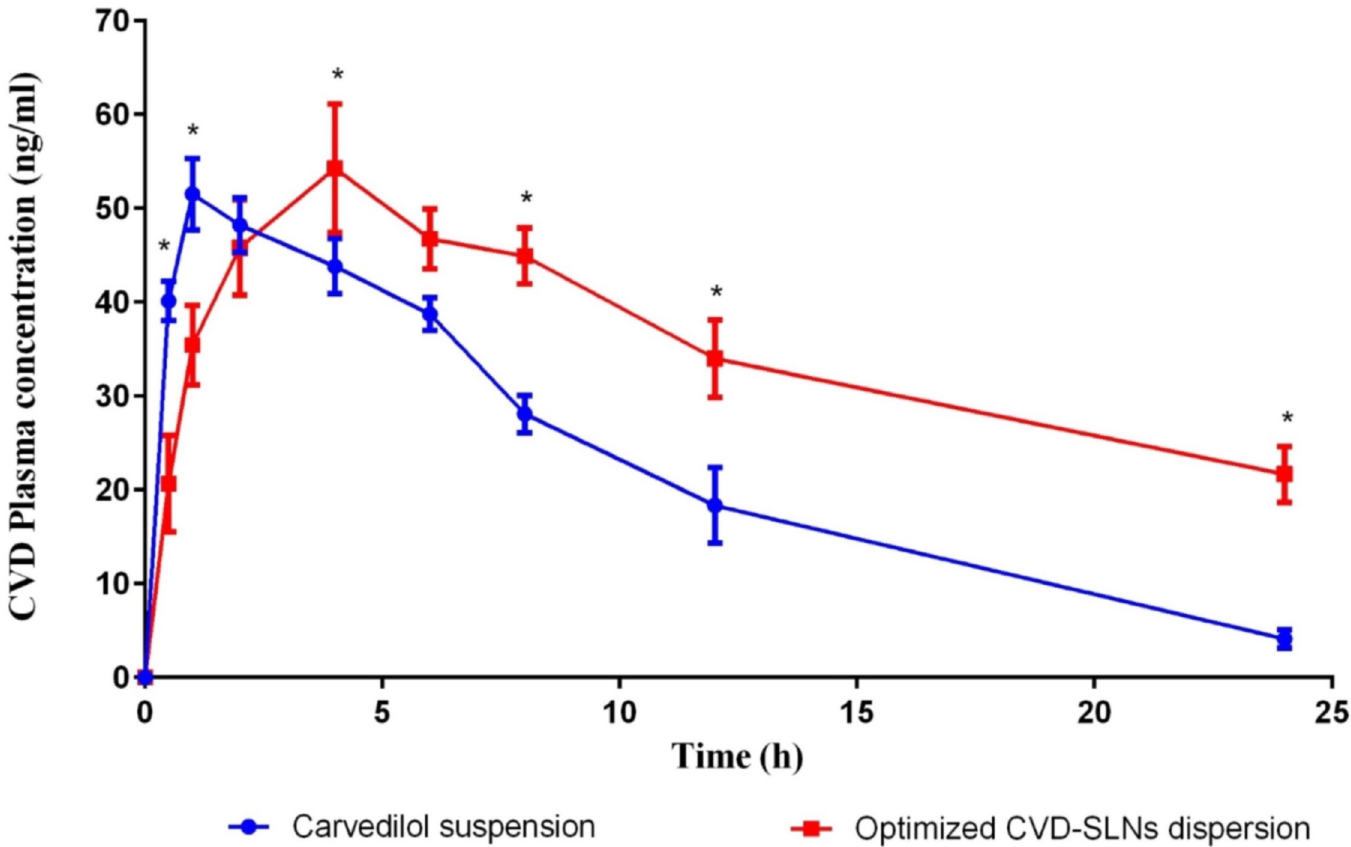
Fig 4. Mean plasma concentration-time profiles for CVD after oral administration of a single dose (1 mg/kg) of the CVD suspension and the CVD-SLNs formulations.